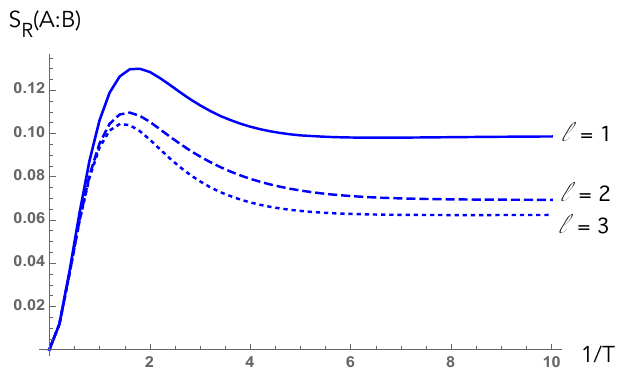
Figure 13 . For the XY model, with { g = 2 , N = 7 , γ = 1 / 2 } , the temperature dependence of the reflected entropy is shown. Under decreasing the size of the B Hilbert space, keeping dim H A fixed, we show that the reflected entropy reduces monotonically for all T